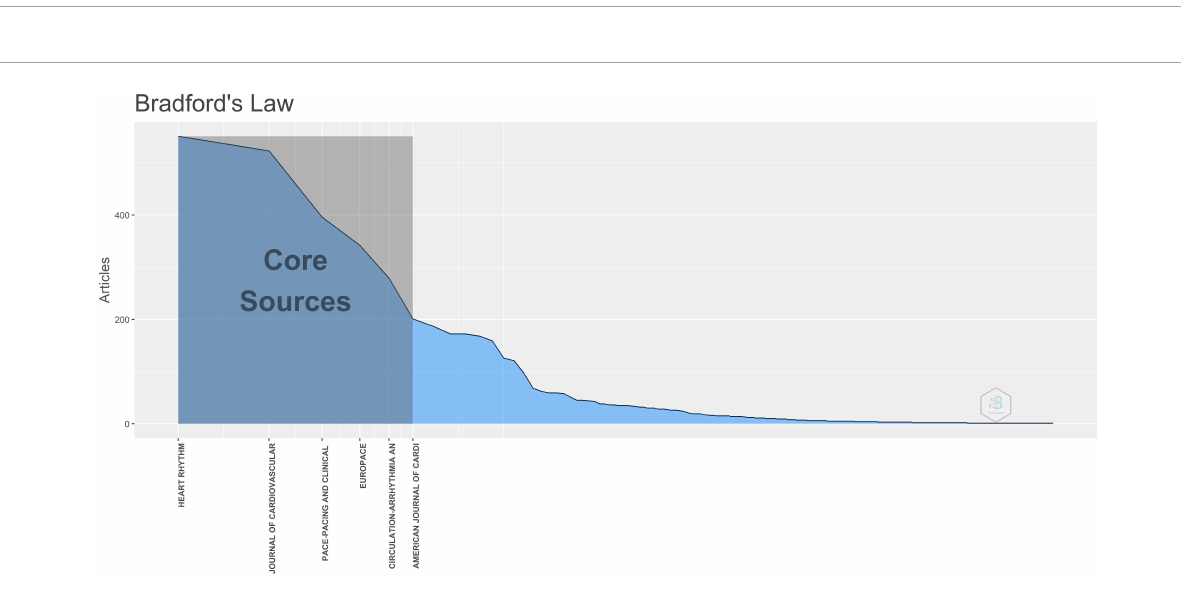
Frontiers in Cardiovascular